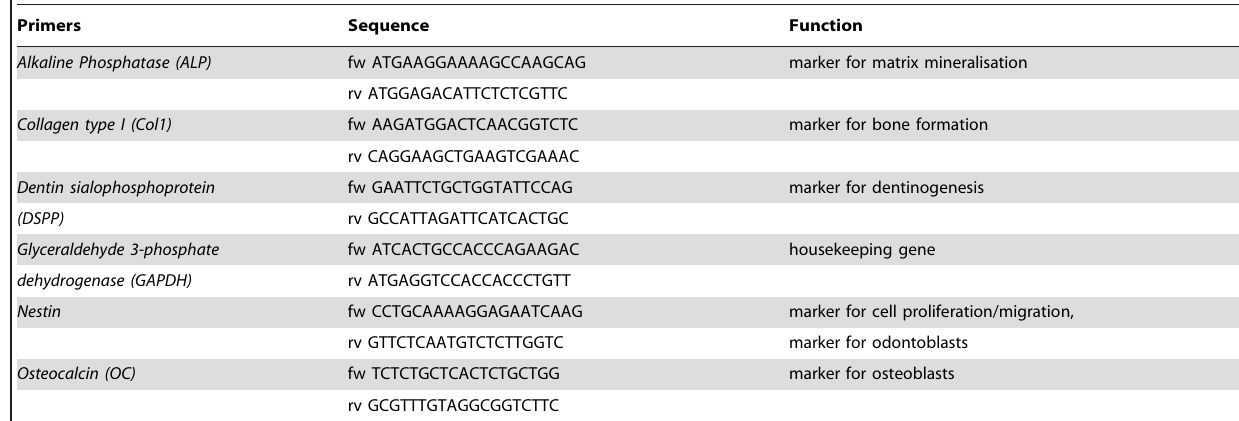
Table 1. Primers used in the study.